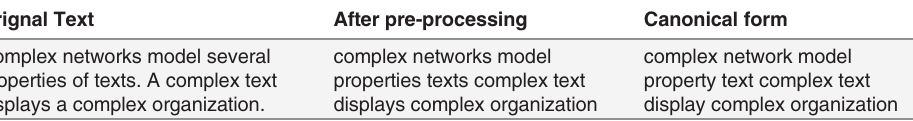
Table 1. Pre-processing